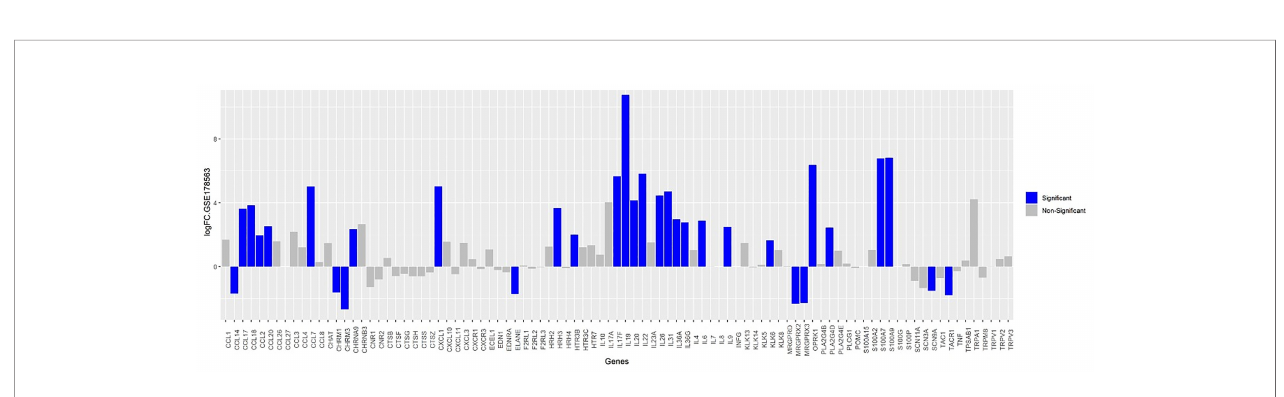
FIGURE 4 | GSEA of raw counts data using Gene Ontology-Biological processes. Pathways upregulated in OS diseased samples are shown in red, while pathways enriched in control samples are shown in blue. Node size indicates size of that gene set, and edge width indicates the similarity coef fi cient between two gene sets.